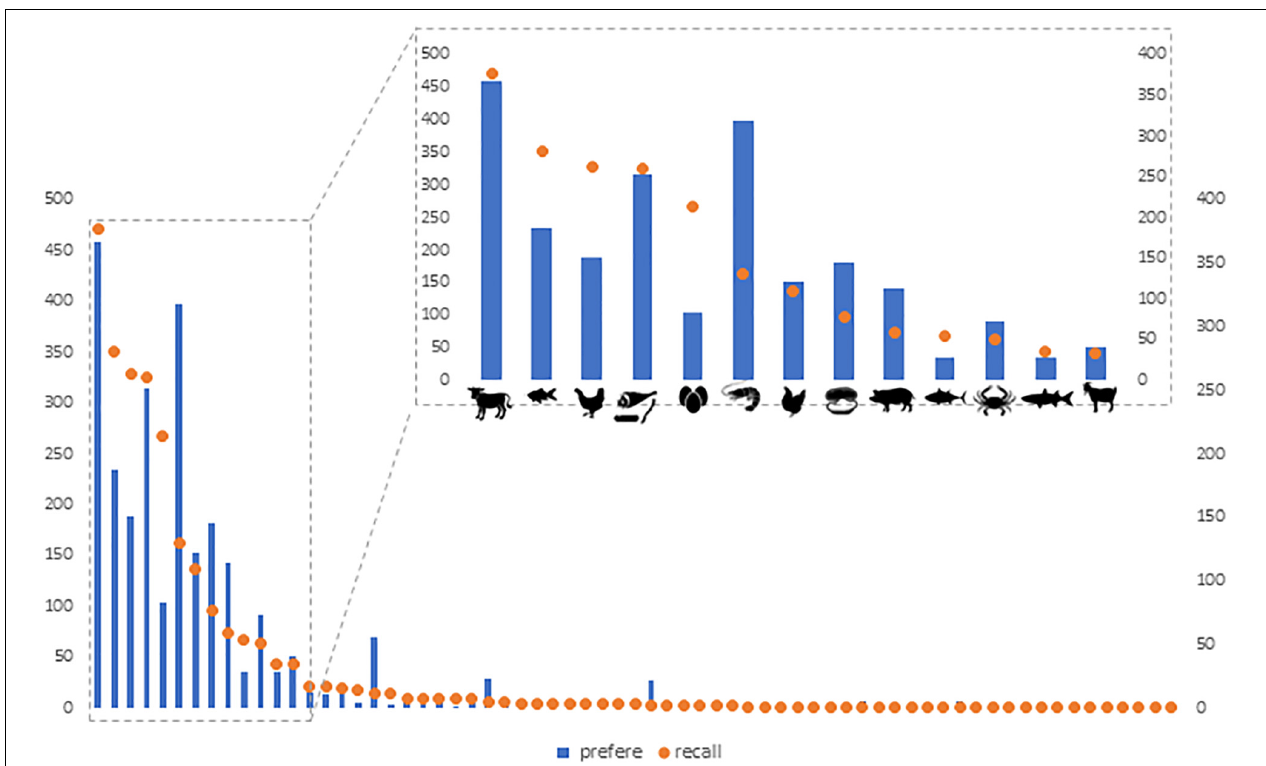
FIGURE 2 | Potiguara students’ consumption (24-h recall) (orange circle) and preference (blue bars) for sources of animal protein. The left Y-axis is the number of consumption events reported per species and the right Y-axis is the number of times the species was mentioned as preferred. Zoomed area shows the 13 most consumed types of meat the day before the